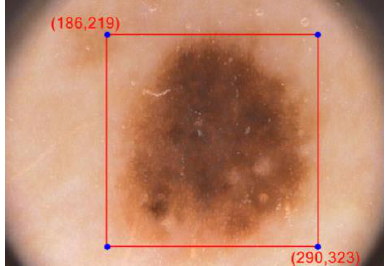
Figure 3. Bounding box in YOLOv3 for image IMD002.